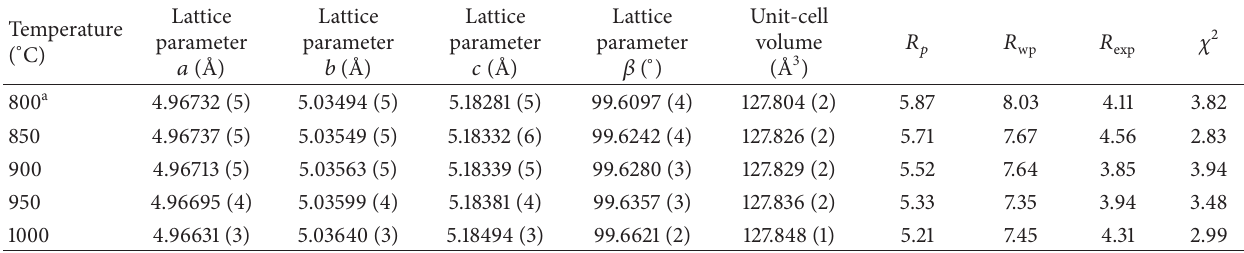
evolution rate for 𝛽 -TaON powders synthesized at 2